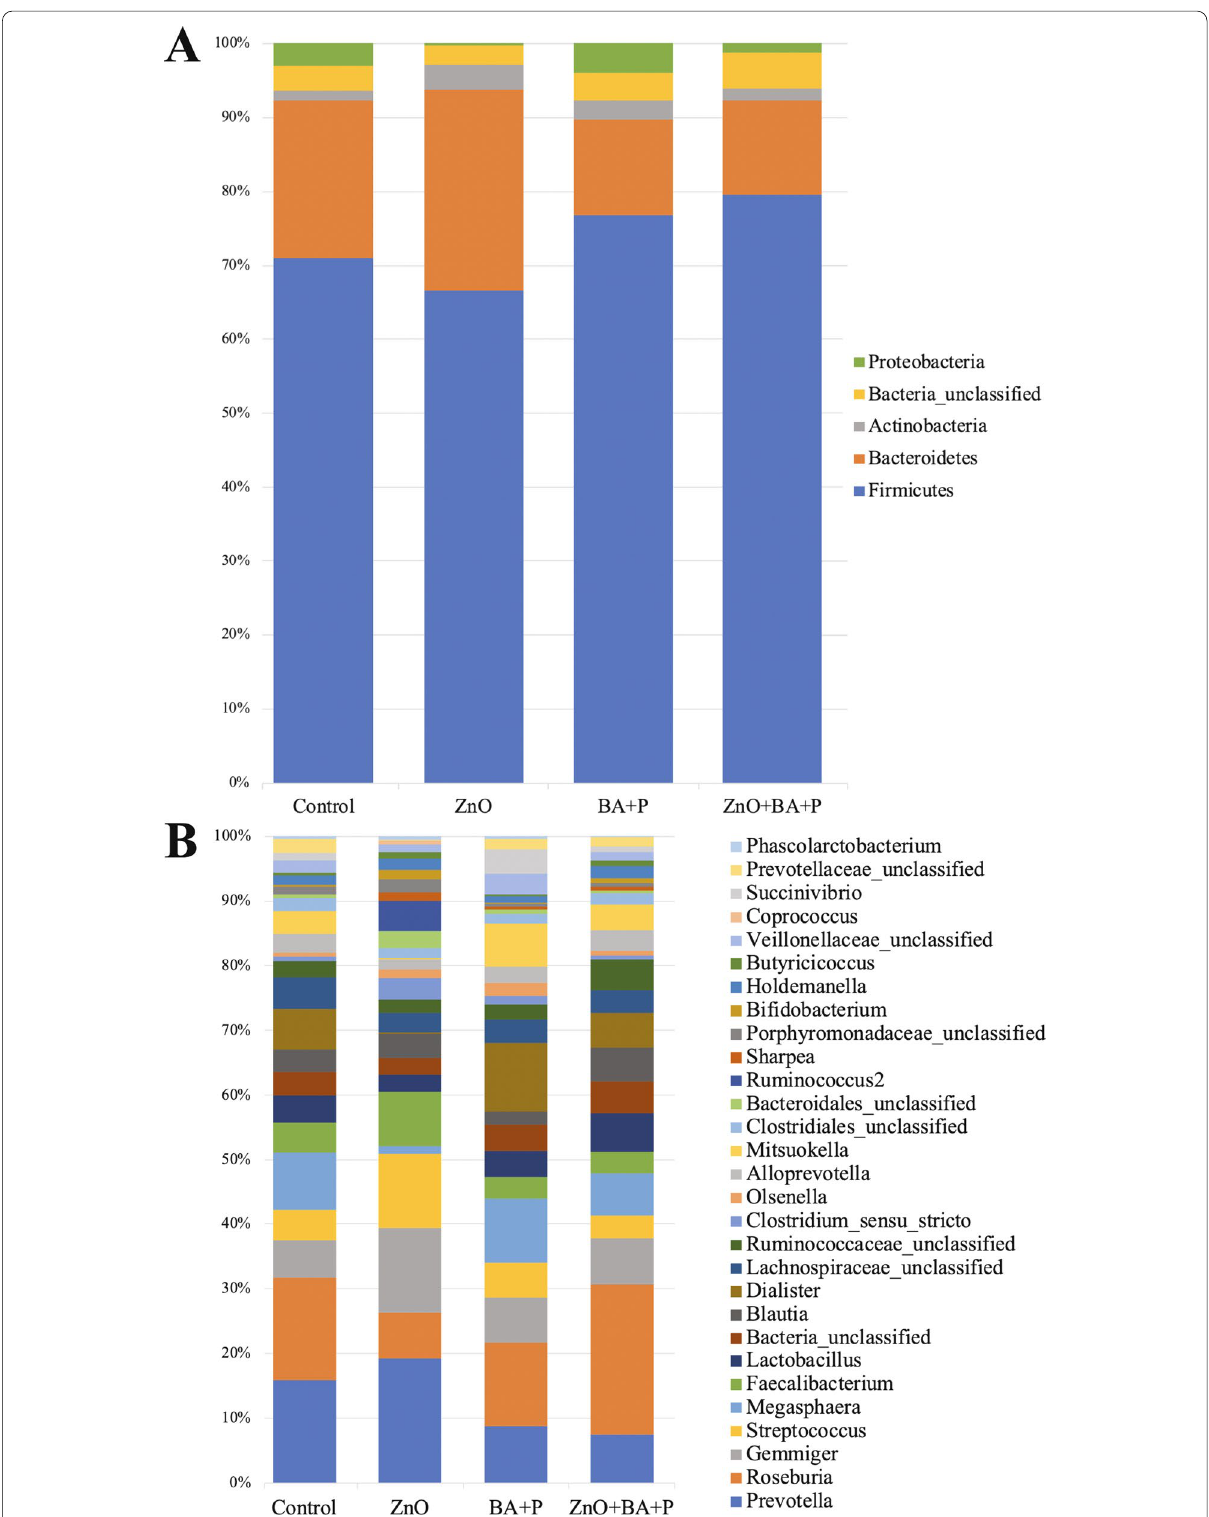
Fig. 1 Relative abundance of the main bacteria found in the swine cecum. Relative abundance of the phyla ( A ) and genera ( B ) with > 1% of abundance present in the cecal microbiota of piglets supplemented with Zinc Oxide (ZnO), Benzoic acid plus probiotics (BA without supplementation